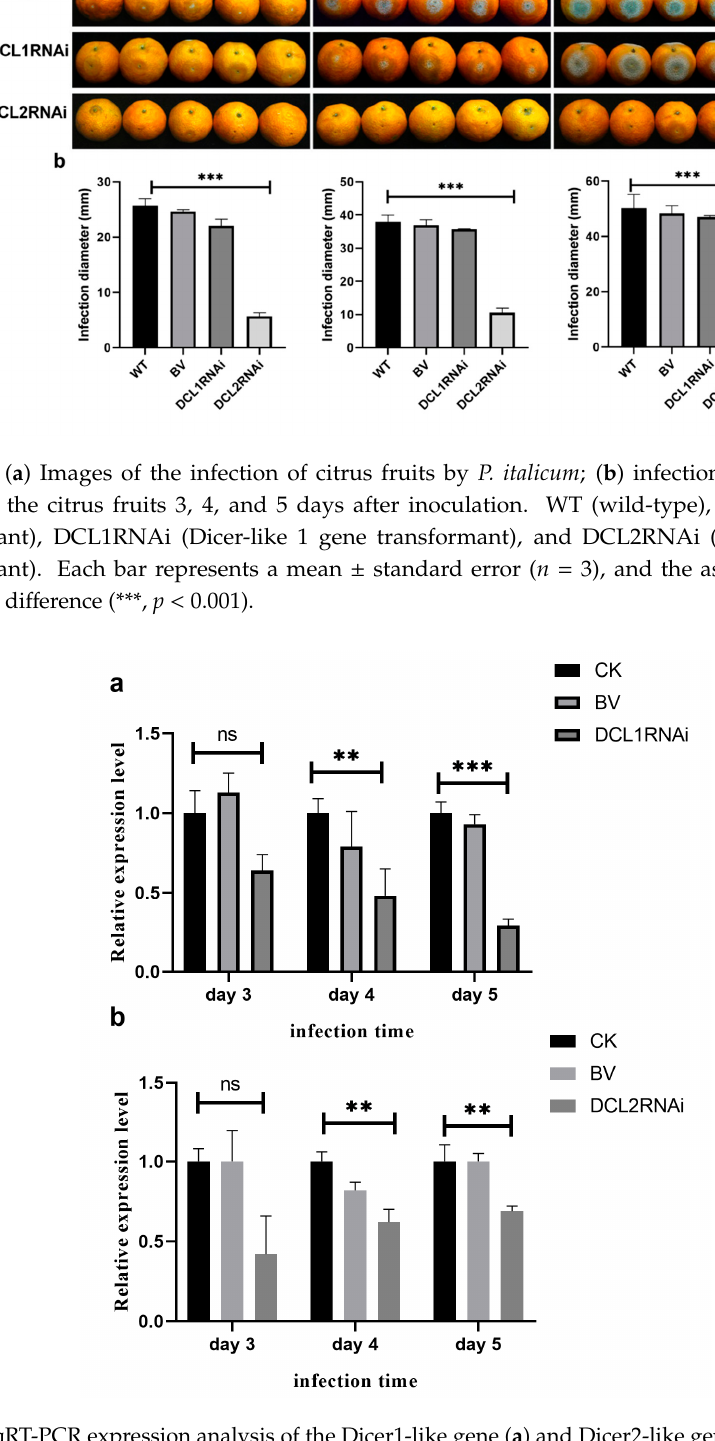
Figure 3. qRT-PCR expression analysis of the Dicer1-like gene ( a ) and Dicer2-like gene ( b ) in P. italicum after inoculation on citrus fruit epidermis for 3, 4, and 5 days. CK (wild-type), BV (blank vector transformant), DCL1RNAi (Dicer-like 1 gene transformant), and DCL2RNAi (Dicer-like 2 gene transformant). Each bar represents a mean ± standard error ( n = 3), and the asterisk indicates a significant difference (**, p < 0.01, ***, p < 0.001), no significance (ns).